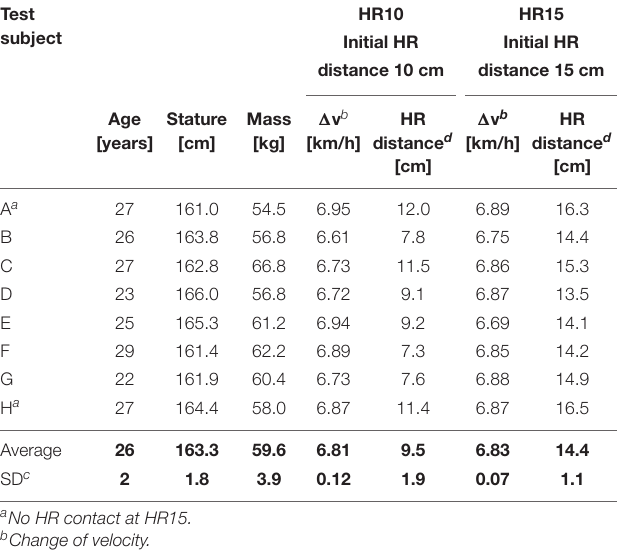
TABLE 1 | The age, stature, mass, (cid:49) v and head-to-HR distance of the individual female volunteers (A–H), as well as their average values and standard deviations